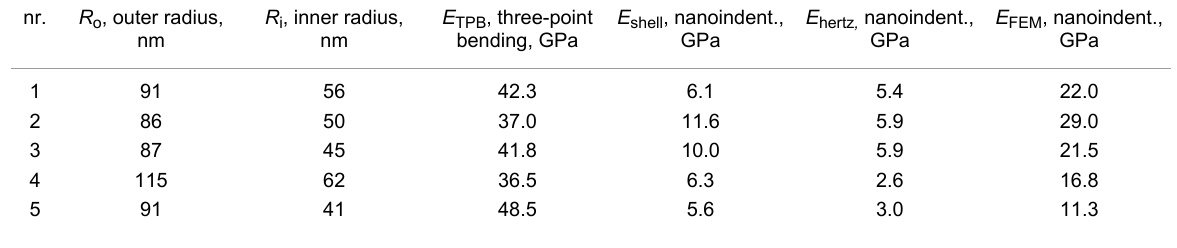
Table 1: Young’s moduli of NTs measured by three-point bending and nanoindentation methods by AFM.